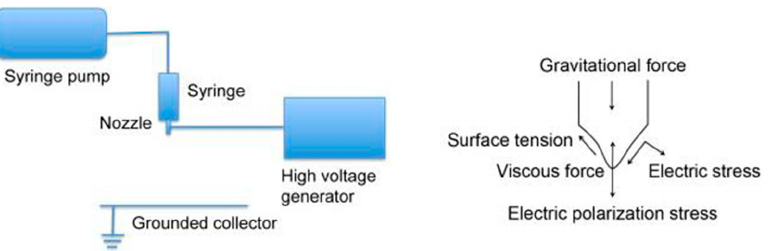
Figure 6. Components in an electrospray setup and the forces acting on Taylor cone; reproduced with permission from [86].